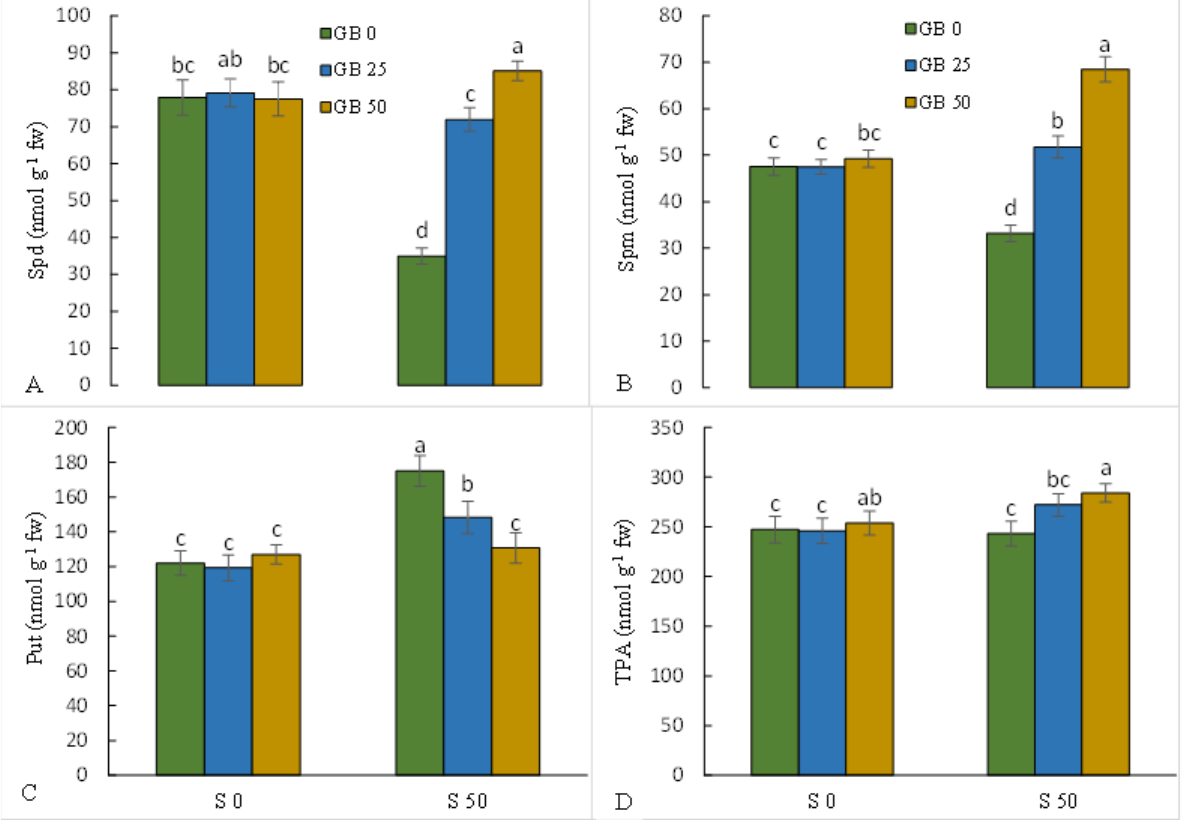
Figure 1. Effect of glycine betaine (GB, 0 and 50 mM) on the leaf contents of spermidine (Spd, ( A )), spermine (Spm, ( B )), putrescine (Put, ( C )), and total polyamine (TPA, ( D )) in the stevia plant under NaCl (0, 25, and 50 mM) treatment. Values (means ± SD, n = 6) followed by the same letter are not significantly different ( p < 0.05; Duncan test).